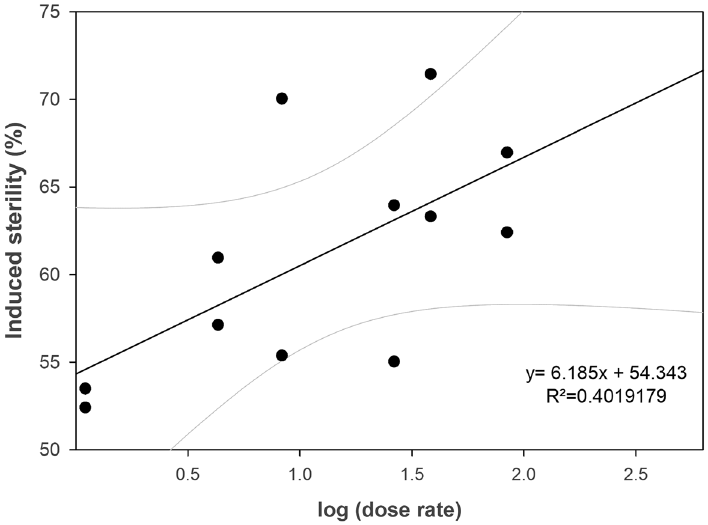
Figure 1. Dose rate response plot showing dose rate effects of Ae. aegypti pupae irradiated with 20 Gy on induced sterility in untreated mated females ( P <